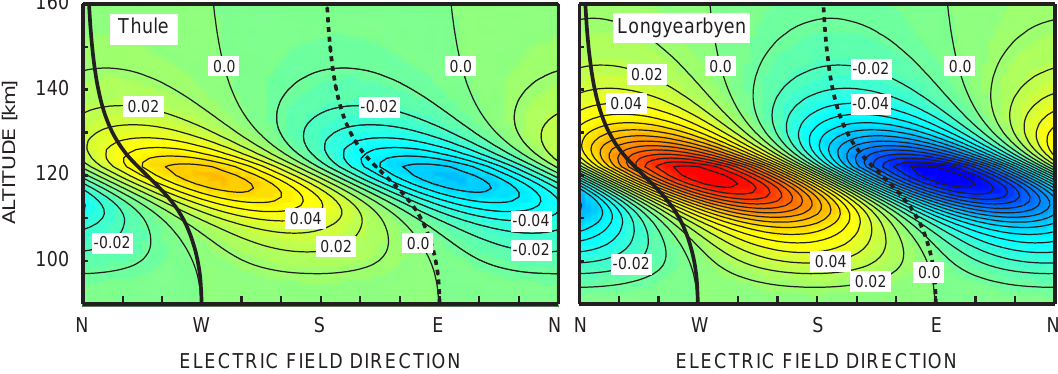
Fig. 1. Convergence of vertical velocity of Fe + ions for different electric field directions and altitudes at Thule and Longyearbyen. The convergence − dv z /dz is normalised by the electric field strength [leading to units (m/(Vs)] and it is shown both in terms of colour and contour plot. MSISE-90 neutral atmospheric model is used at magnetic midnight in summer at each site. The continuous and dashed heavy lines indicate the altitudes of the convergent and divergent nulls, respectively.